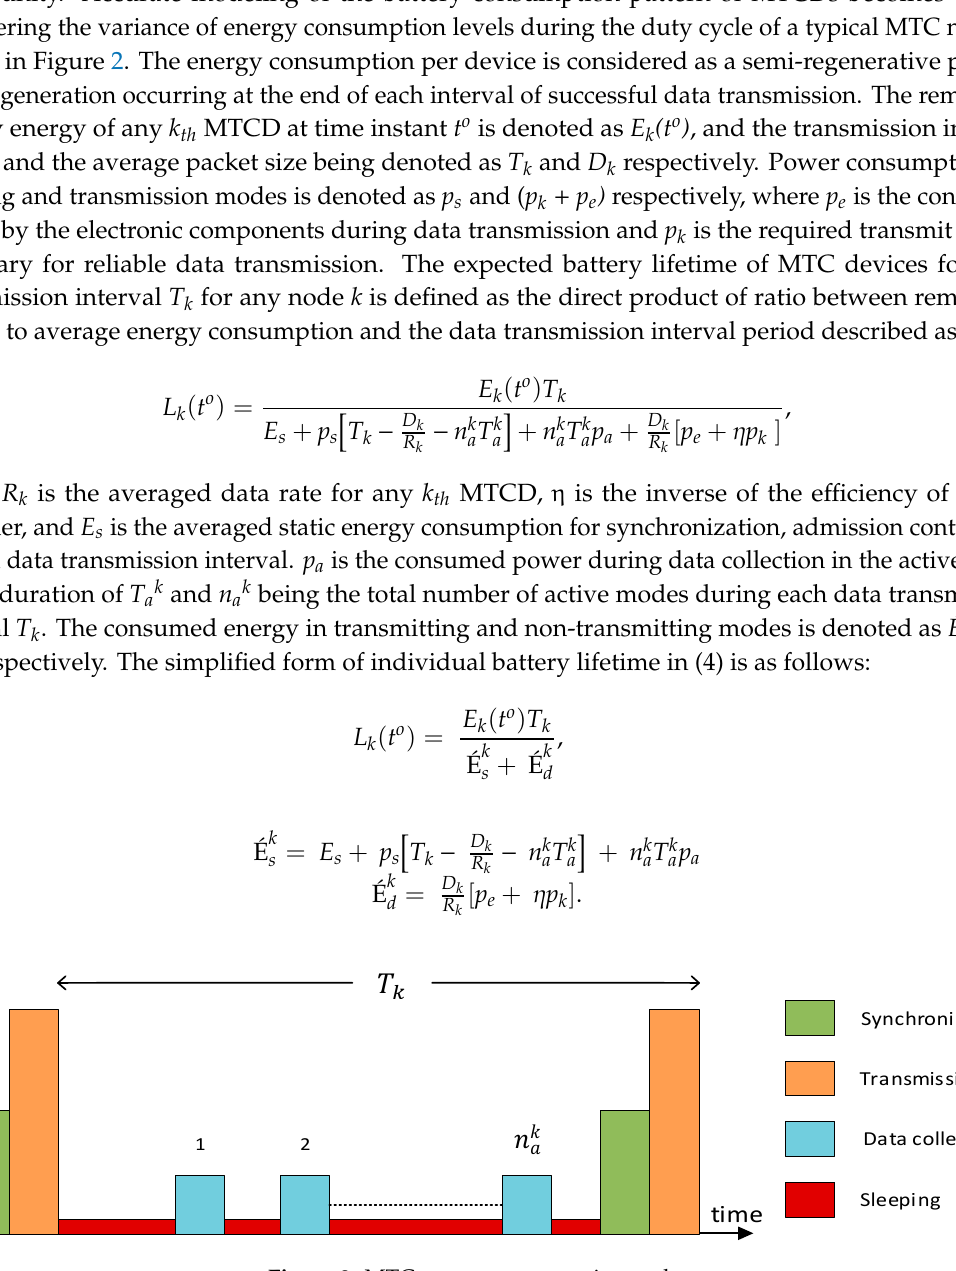
Figure 2. MTC energy consumption cycle.